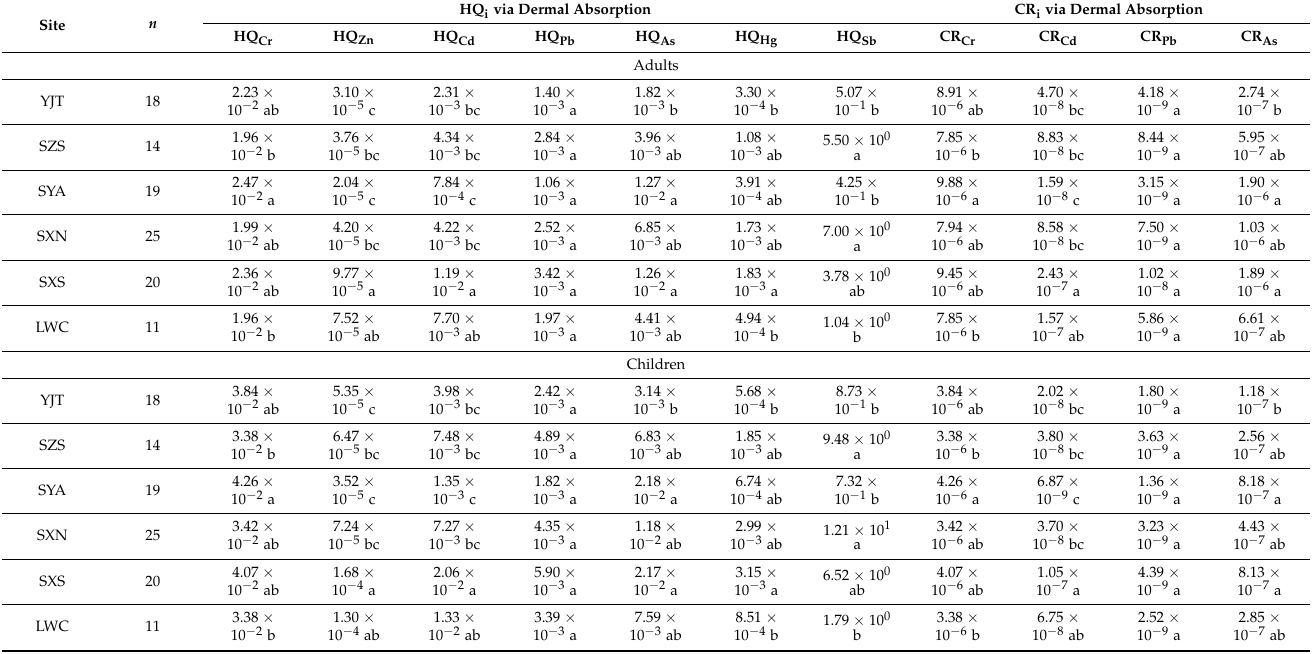
Table 5. Non-carcinogenic hazards (HQ i ) and carcinogenic risk (CR i ) index of PTEs by dermal absorption. Site